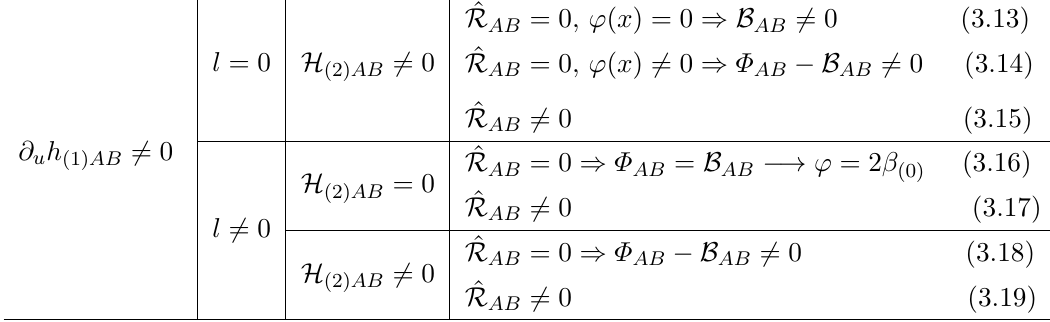
6 = 0 . The cases such that ∂ u h (1) AB